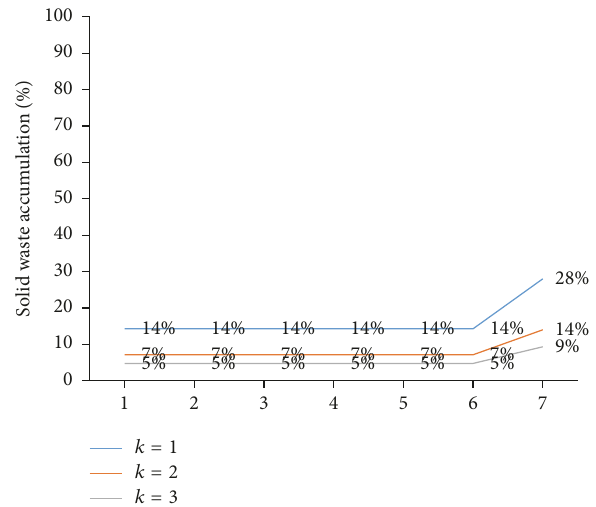
Figure 5: Solid waste accumulation per day 𝑡 for 𝑝 = 12 and 𝑘 = 1, 2,3